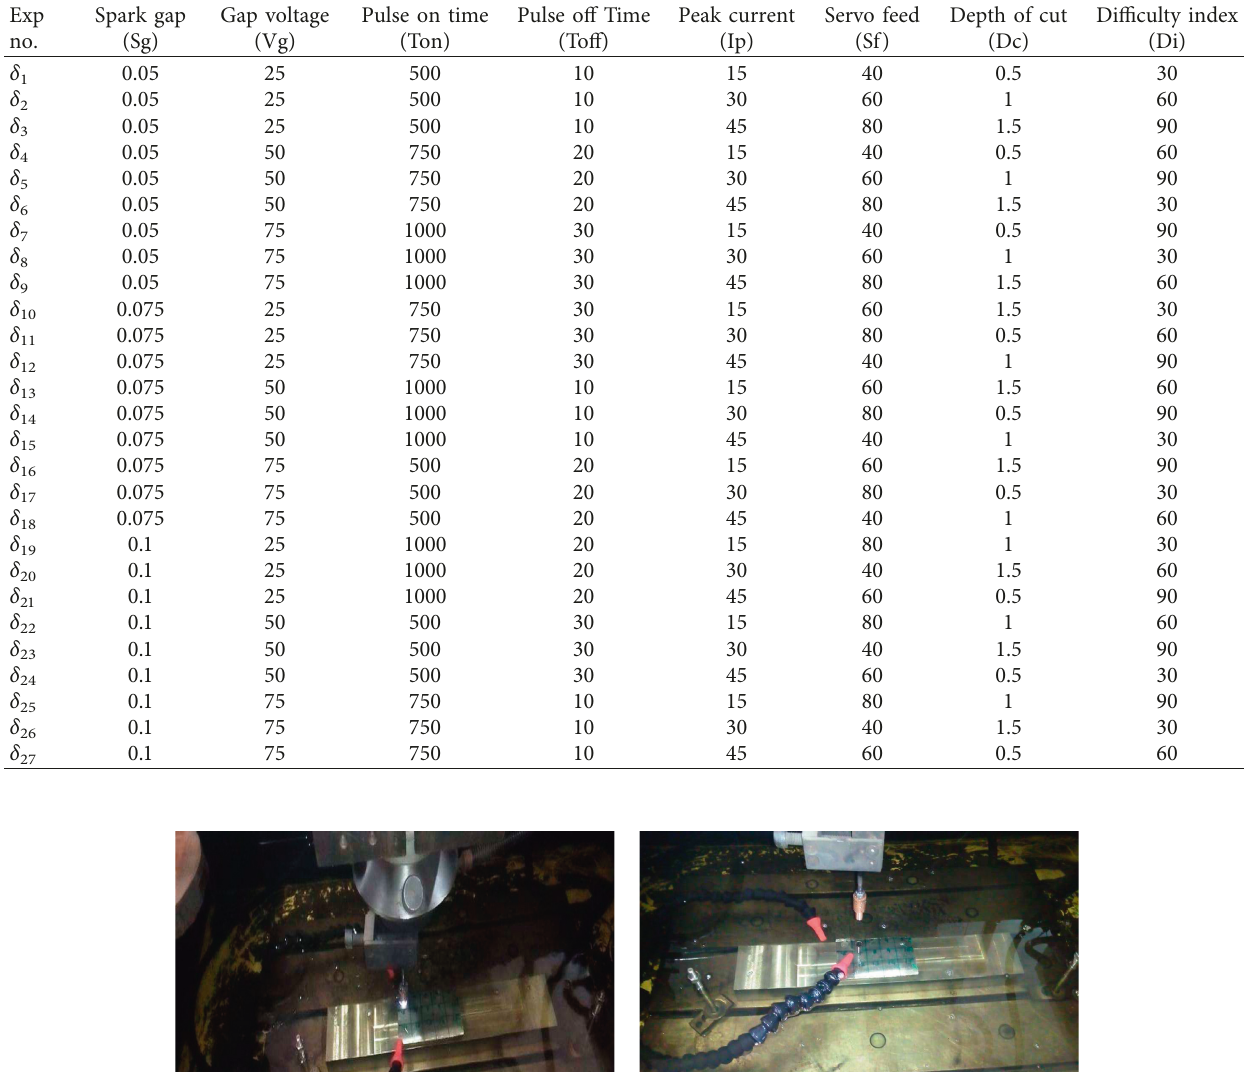
Table 6: Taguchi’s L 27 orthogonal array structure.